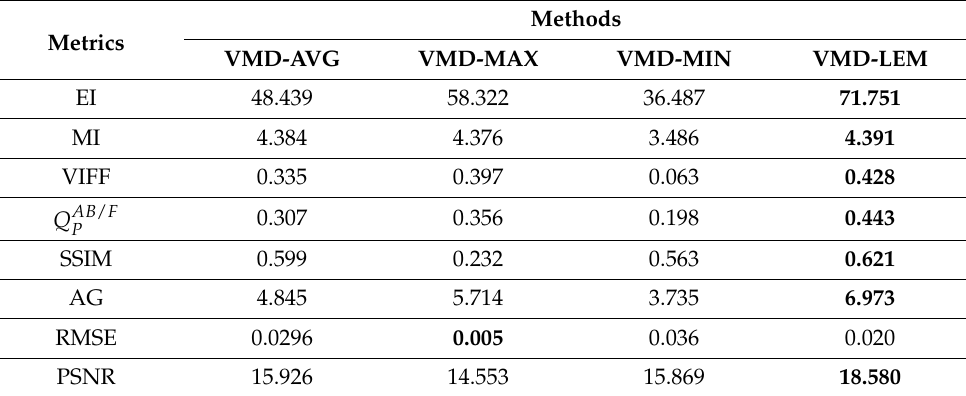
Table 2. Average quantitative analysis of various fusion rules on 10 pairs of MRI-CT